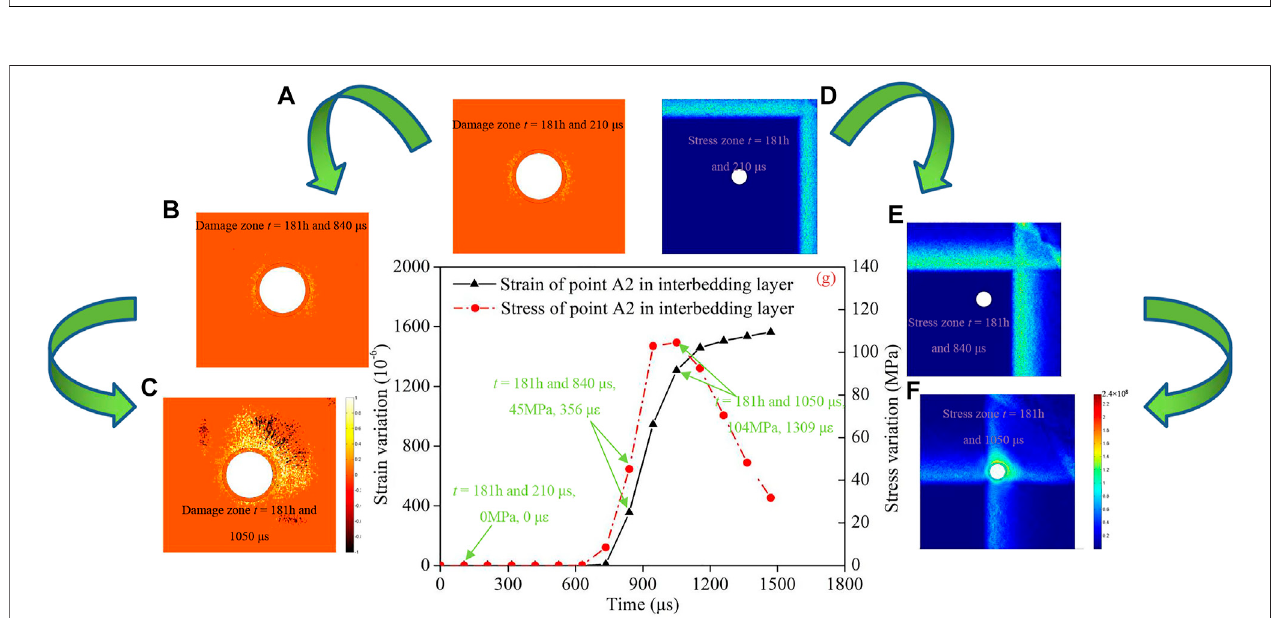
FIGURE 8 | Results of the numerical simulation prediction. (A) Distribution ofthe damage area of the surrounding rheological rockmass of a shaft; (B) Deformation law of the surrounding rockmass points A2 of a shaft.